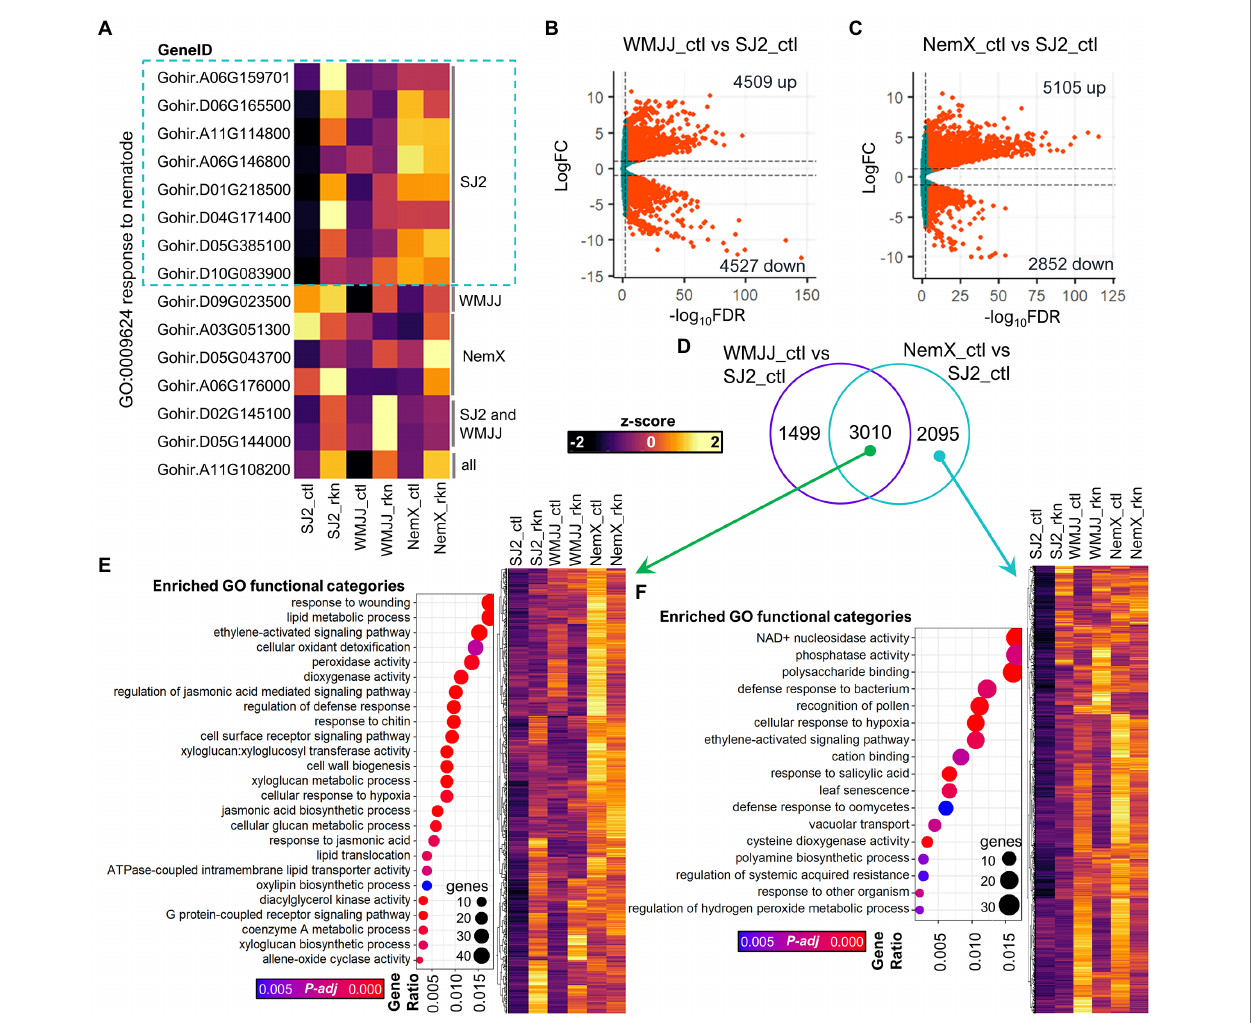
FIGURE 3 | Expression profiling analysis revealed constitutive activation of nematode-related and defense-response related genes in the NemX accession. (A) Heatmap of the expression of genes included in the GO:0009624 response to nematode functional category. (B,C) Volcano plots of differential basal expression in WMJJ (B) and NemX (C) cultivars vs. SJ2. (D) Venn analysis of the differentially expressed genes presented in (B,C) . (E,F) GO enrichment analysis of the genes with more basal expression in WMJJ and NemX (E) and of those that are specific to NemX (F)